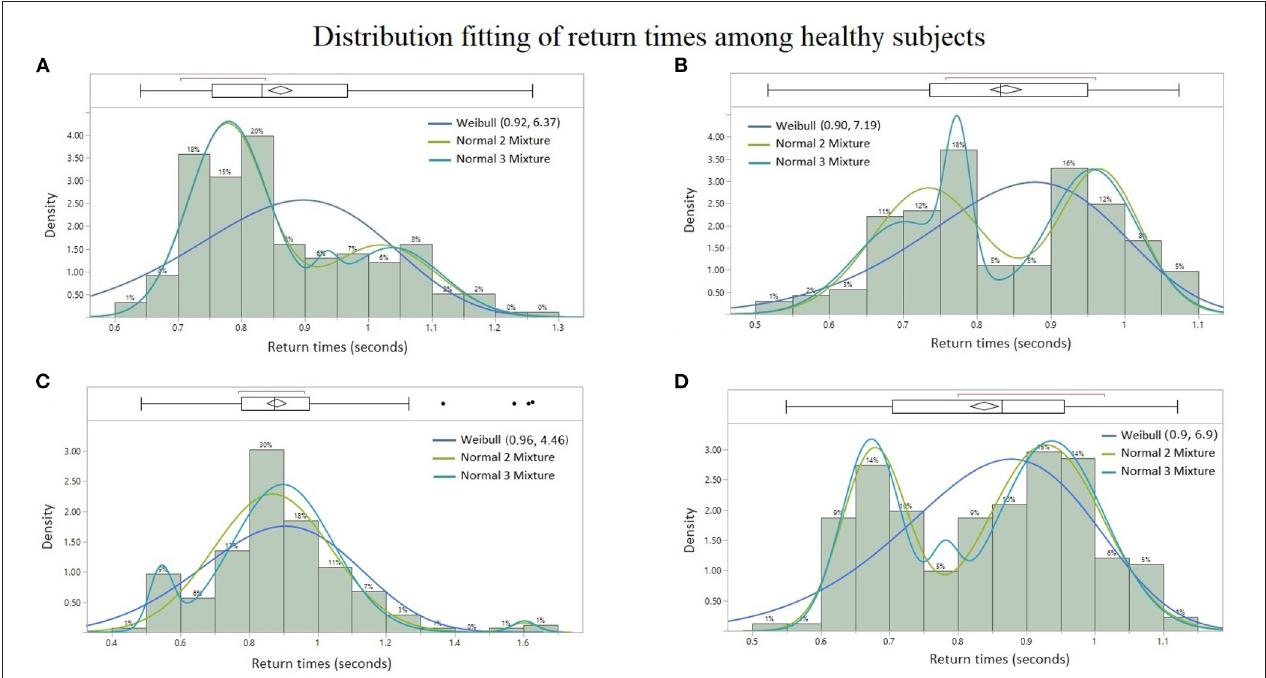
FIGURE 6 | Probability distribution fitting of return times from healthy subjects: (A) lumbar spine signal of Subject #6 with Normal 2 Mixture ( AICc = − 272.53), Normal 3 Mixture ( AICc = − 265.98), and Weibull ( AICc = − 199.41), (B) sacral signal of Subject #8 with Normal 3 Mixture ( AICc = − 187.61), Normal 2 Mixture ( AICc = − 186.31), and Weibull ( AICc = − 167.78), (C) cervical signal of Subject #5 with Normal 3 Mixture ( AICc = − 95.26), Normal 2 Mixture ( AICc = − 87.19), and Weibull ( AICc = − 51.56), and (D) cervical signal of Subject #8 with Normal 2 Mixture ( AICc = − 236.16), Normal 3 Mixture ( AICc = − 230.59), and Weibull ( AICc = − 194.86). Lower AICc values indicate a better distribution fit.